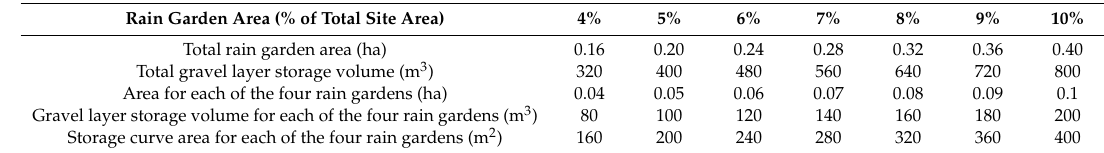
Table A6. Areas of the rain gardens and the corresponding gravel storage volumes adopted for the study.